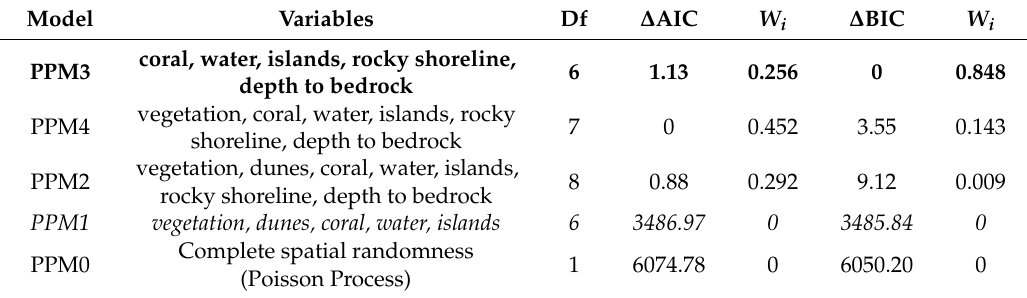
Table 2. Results of comparing the di ff erent inhomogeneous Poisson point process models using ∆ AIC, ∆ BIC and their associated weights. PPM3 and PPM4 were the best fitting models according to stepwise model selection using Bayesian Information Criterion (BIC) and Akaike Information Criterion (AIC), respectively. We chose PPM3 (bold text) because it is the simpler of the two models PPM1 (italicized) represents the Davis et al. ([49]) model. Df = degrees of freedom; W i = information criterion weight value.